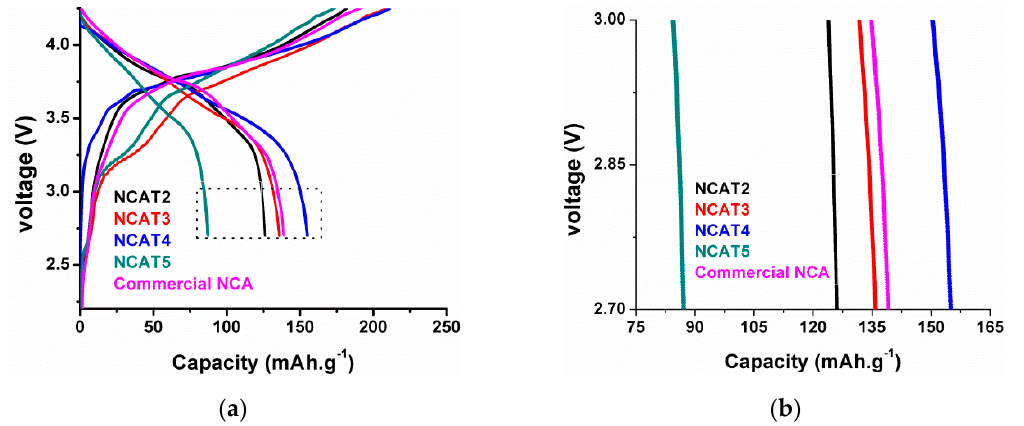
Figure 12. ( a ) Charge—discharge curve of as-prepared NCA samples at various sintering temperature and ( b ) magnified portion of the graph.